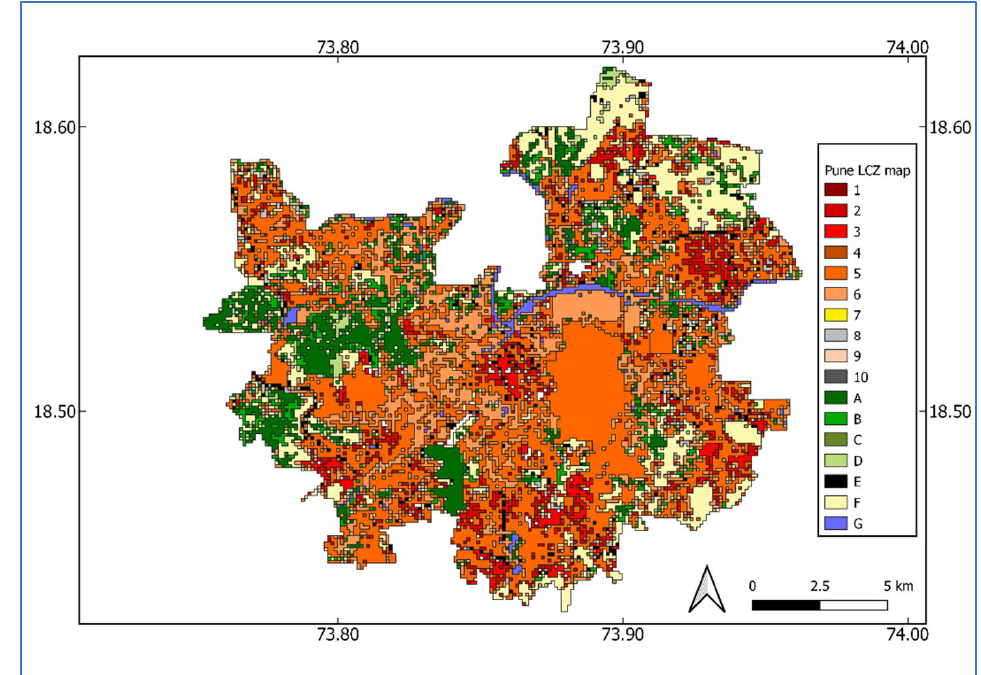
Figure 4. Local climate zones of Pune city as per WUDAPT with Landsat 8 (2020).